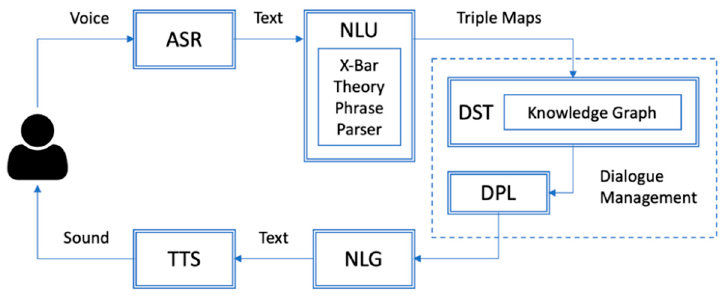
Figure 2. Dialogue system module architecture integrating knowledge graph.